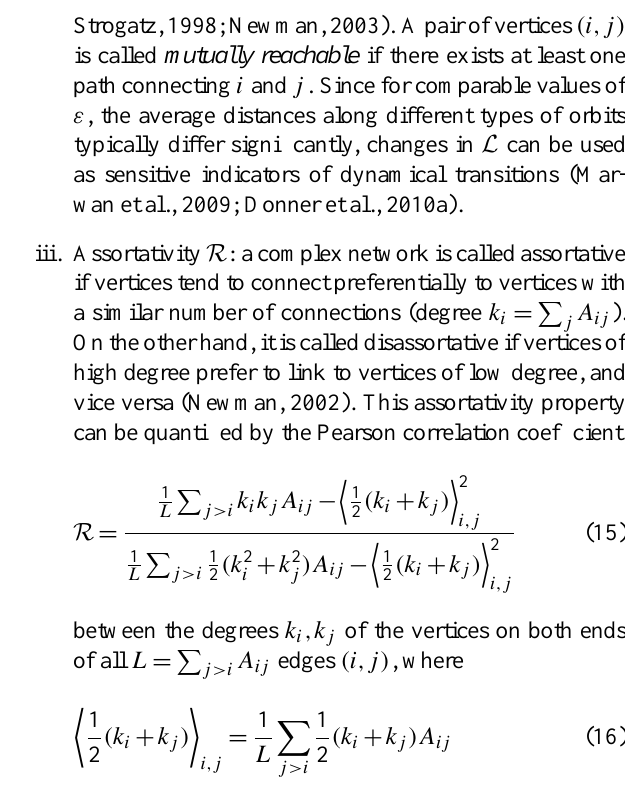
Fig. 6. Recurrence networks obtained from the dust flux record at ODP site 659, centred around (A) 1.2, (B) 2.2, and (C) 3.2 Myr BP and corresponding to the recurrence plots of Fig. 5. Vertex color indicates the age t µ associated to single state vectors µ (from blue [=old] to red [=young]). The two-dimensional graph visualisation has been obtained with the software package GUESS using a force-directed placement algorithm (http://graphexploration.cond.org). It is important to note that in this visualisation, node positions are determined by the aforementioned algorithm and do not correspond to a projection of the node coordinates in the reconstructed three-dimensional phase space.